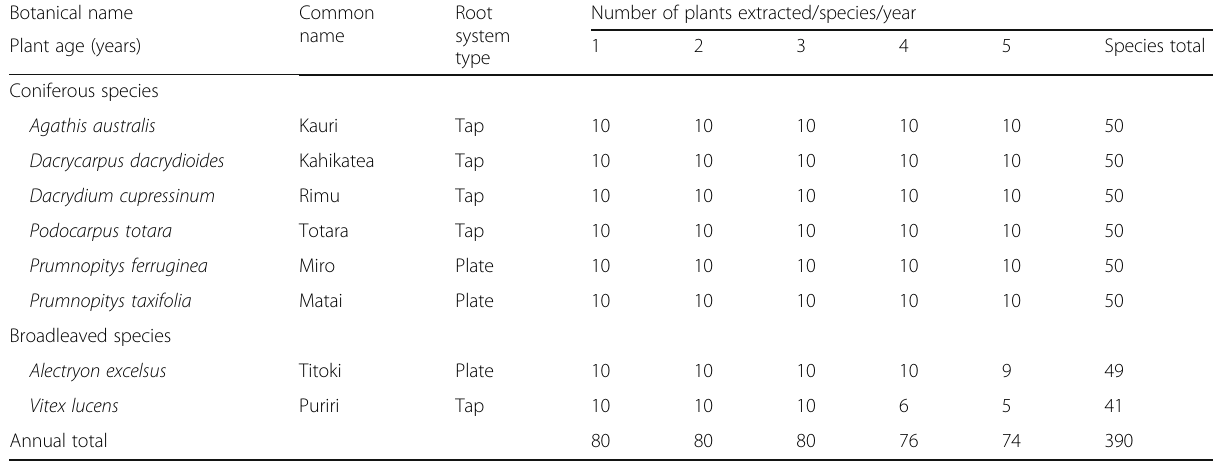
Table 1 Indigenous conifers and broadleaved species trialled and number of trees extracted each year of the